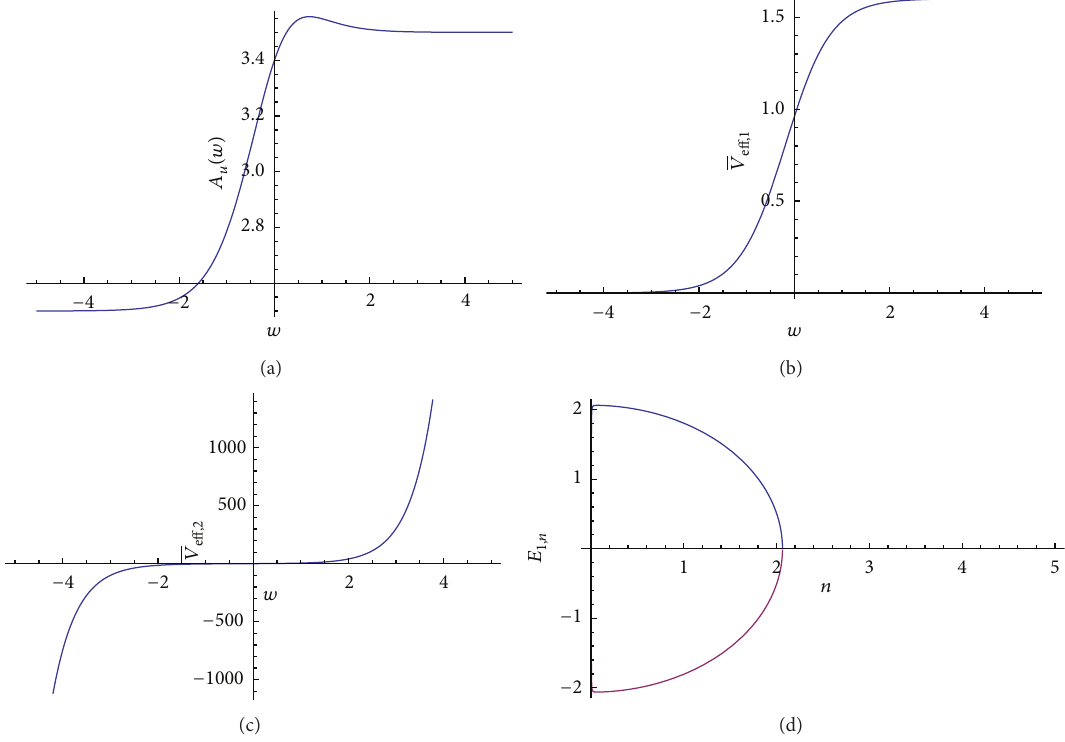
(22) and (c) 𝑉 (23) for the values eff ,1 eff ,2